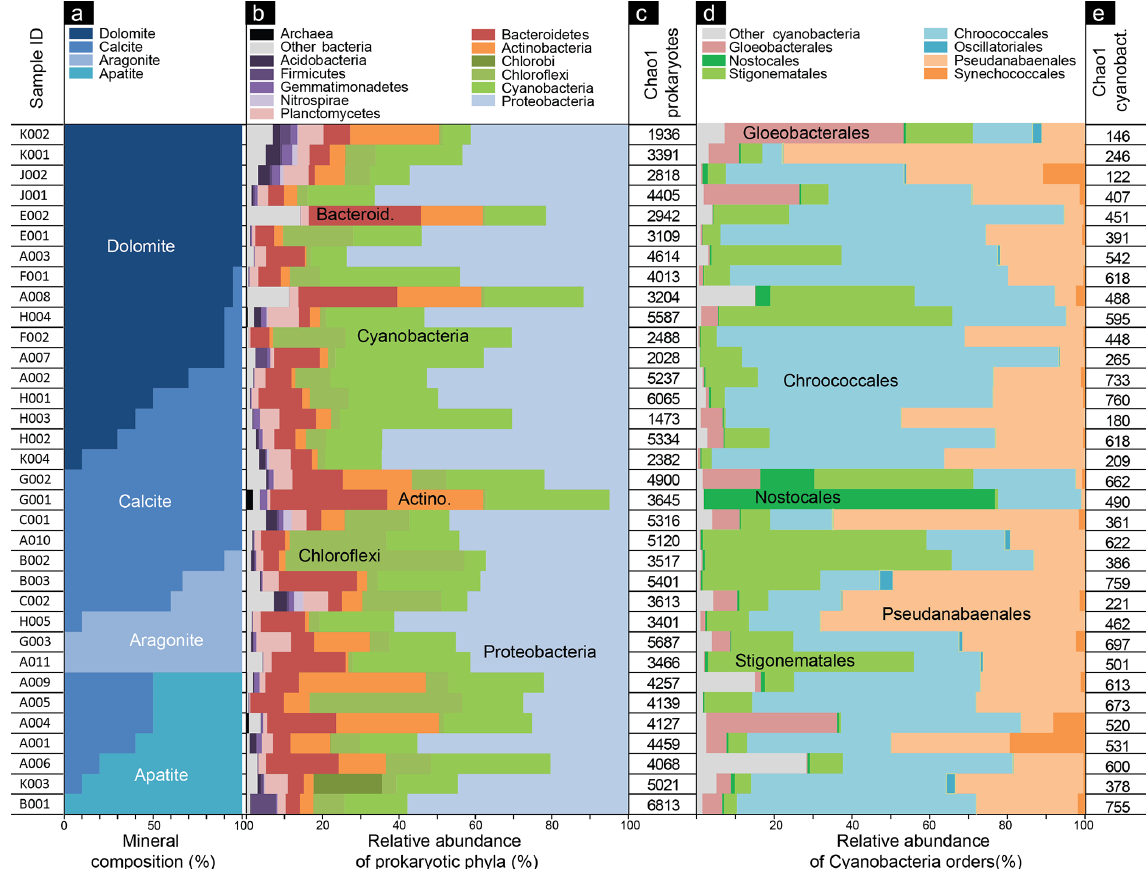
Figure 2. Mineral composition and microbial community structure of Isla de Mona intertidal outcrops. Each line corresponds to one sample. (a) Mineralogical composition as retrieved by bulk powder XRD. (b) Distribution of 16 rDNA OTUs taxonomically assigned at the phylum level and (c) associated chao1 richness metric. This reflects the total microbial community structure. (d) Distribution of the cyanobacterial 16 rDNA OTUs assigned at the phylum level, excluding chloroplasts and associated chao1 richness metric for cyanobacteria (e) .